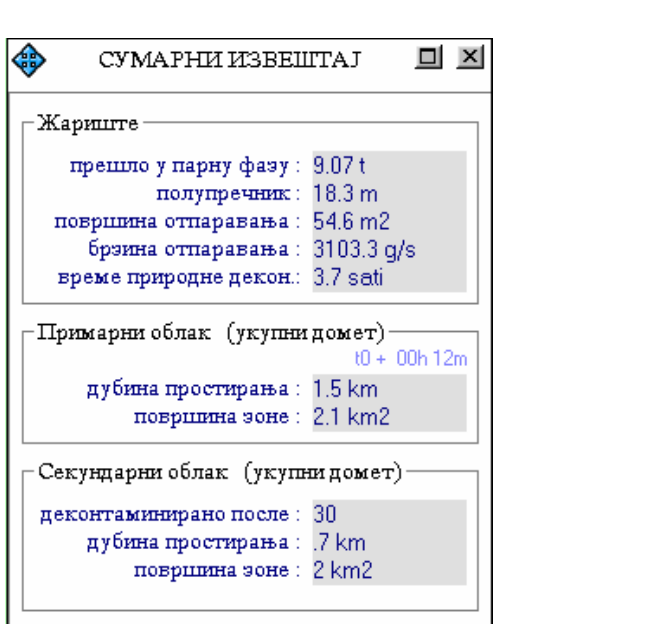
Slika 5 – Izgled sumarnog izveštaja Figure 5 – Layout of the summary